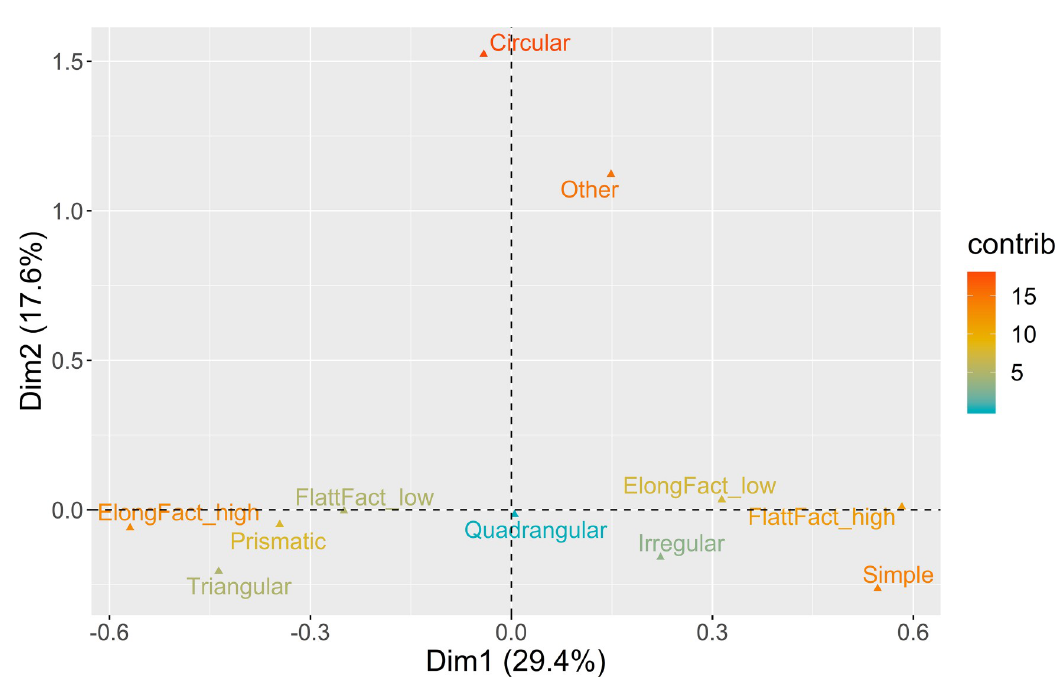
Fig 13. Multiple correspondence analysis plot (first two dimensions) for core morphology. The color ramp represents the contribution (in %) of the variable categories to the definition of the dimensions.